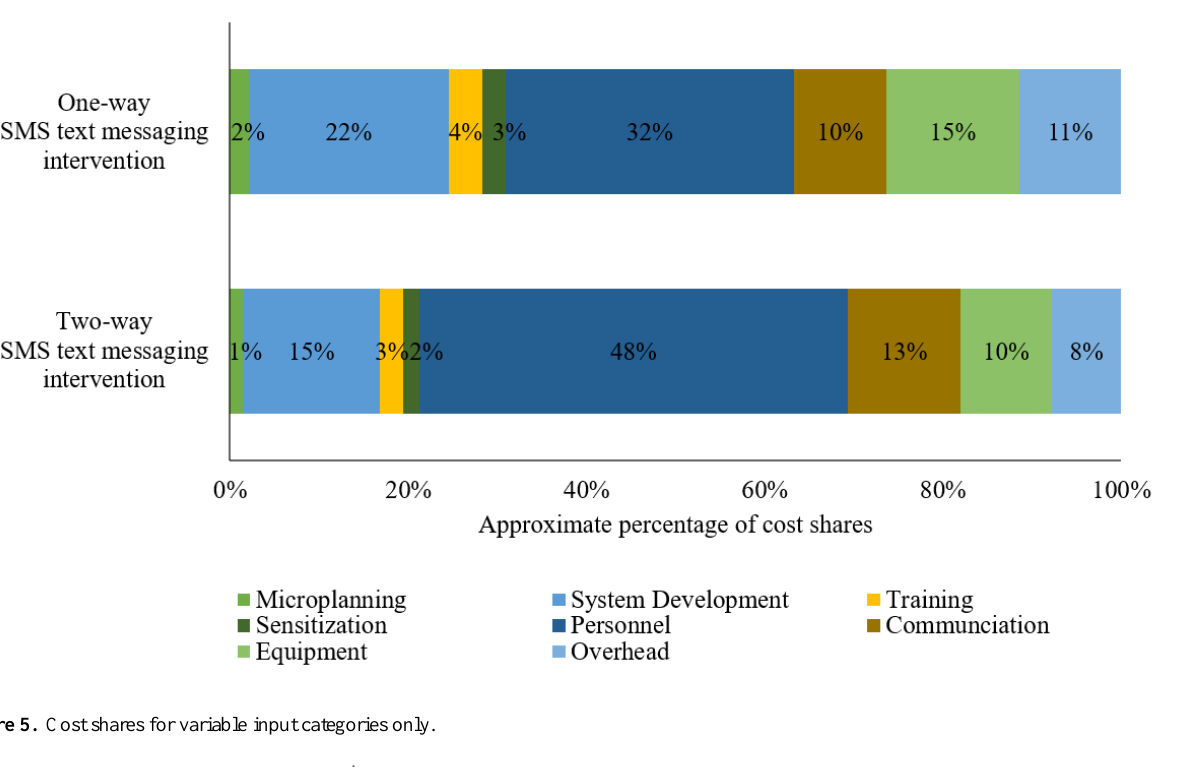
Figure 4. Cost shares by input categories for all costs.